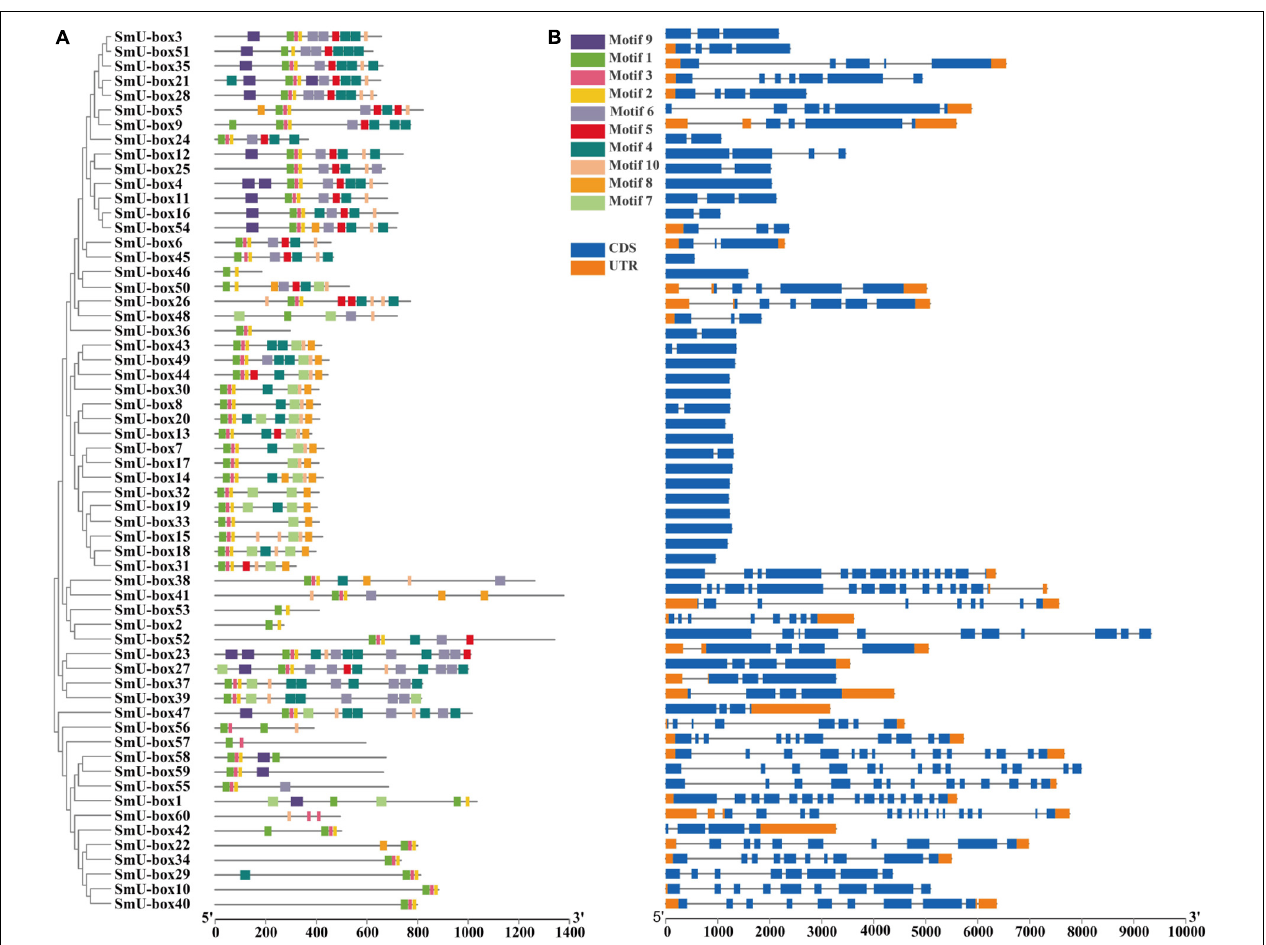
FIGURE 2 | The conserved motifs and gene structure analysis of U-box gene family in S. miltiorrhiza . (A) Distribution of ten motifs in all of the U-box proteins in S. miltiorrhiza . A total of 10 motifs were predicated and named motif 1–10. A neighbor-joining (NJ) phylogenetic tree of 60 S. miltiorrhiza U-box genes was constructed by Mega 6.0 with 1,000 bootstraps. (B) The gene structure of U-box genes in S. miltiorrhiza . The blue rectangles represented CDS, and the orange rectangles represented